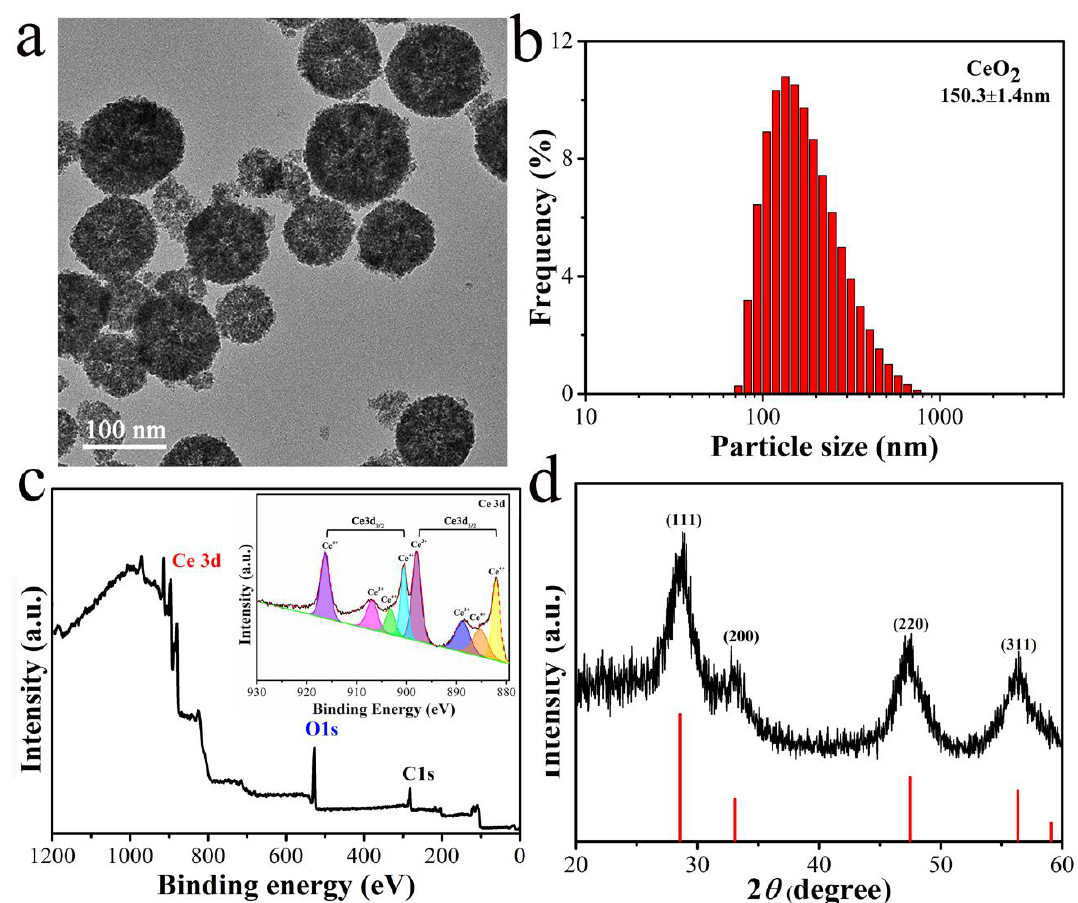
Figure 1. The characterization of CeO 2 nanozyme. ( a ) TEM images of CeO 2 ; ( b ) the dynamic light scattering (DLS) analysis of CeO 2 ; ( c ) the XPS spectra of the CeO 2 nanozyme; the inset shows the high-resolution XPS spectra of Ce3d; ( d ) the XRD pattern of CeO 2 (black curve).